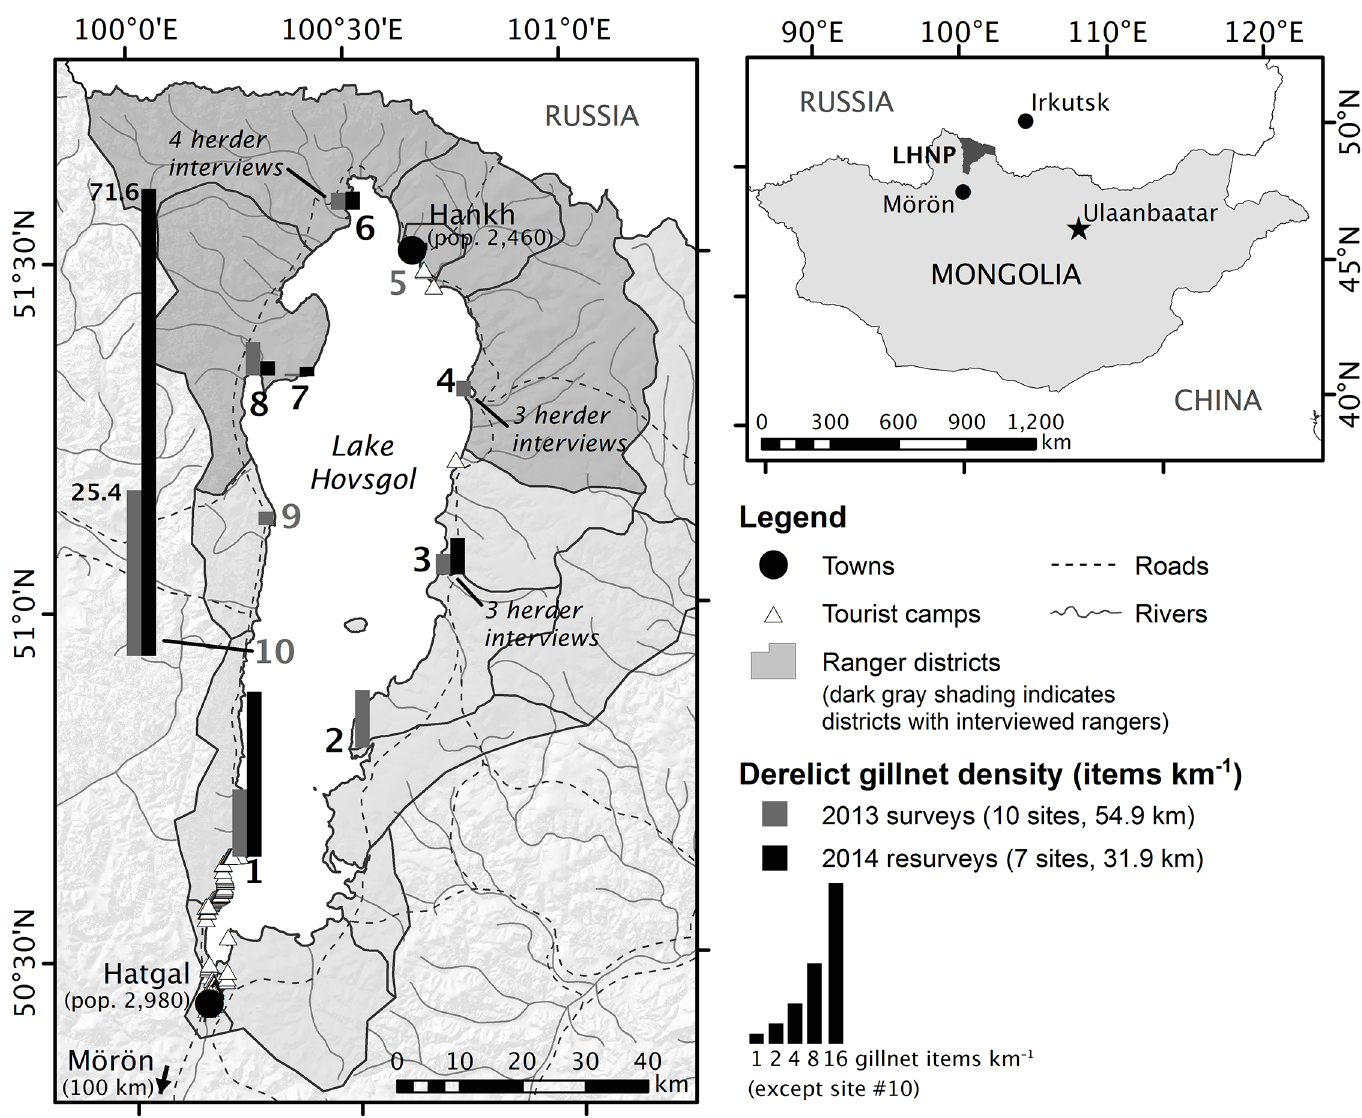
Fig 1. Location of shoreline surveys for derelict fishing gear, fish population monitoring sites, and interviews with park rangers and resident herders in Lake Hovsgol National Park (LHNP), Mongolia. Grey and black bars indicate the density (# km -1 ) of derelict gillnet items observed in the 2013 (n = 10) and 2014 (n = 7) surveys, respectively (note different y-axis scale for Site 10). Black site numbers indicate the seven sites where fish population monitoring surveys were conducted in 2009 and 2011 – 13. Solid black lines indicate the park boundary and 17 ranger districts. Five rangers from five districts (dark grey; Hankh town limits represent one district) were interviewed. Herders were interviewed at Sites 3 (n = 3), 4 (n = 3), and 6 (n = 4). Small white triangles indicate tourist camps, large black circles indicate town centers, dotted black lines indicate primitive roads, and solid gray lines indicate rivers and seasonal